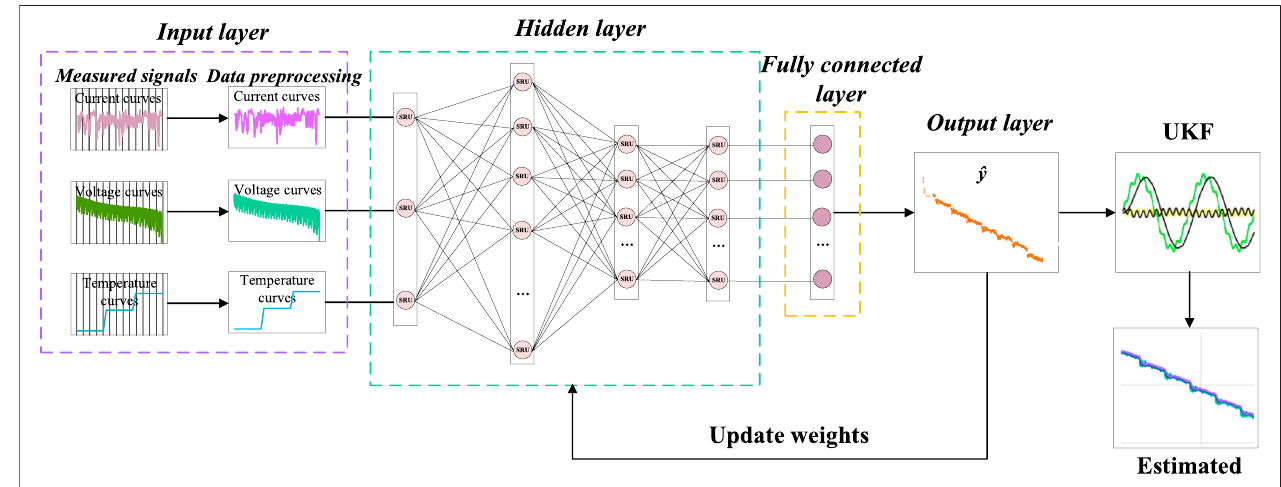
FIGURE 3 | The SRU – UKF structure for SOC estimation of the lithium-ion